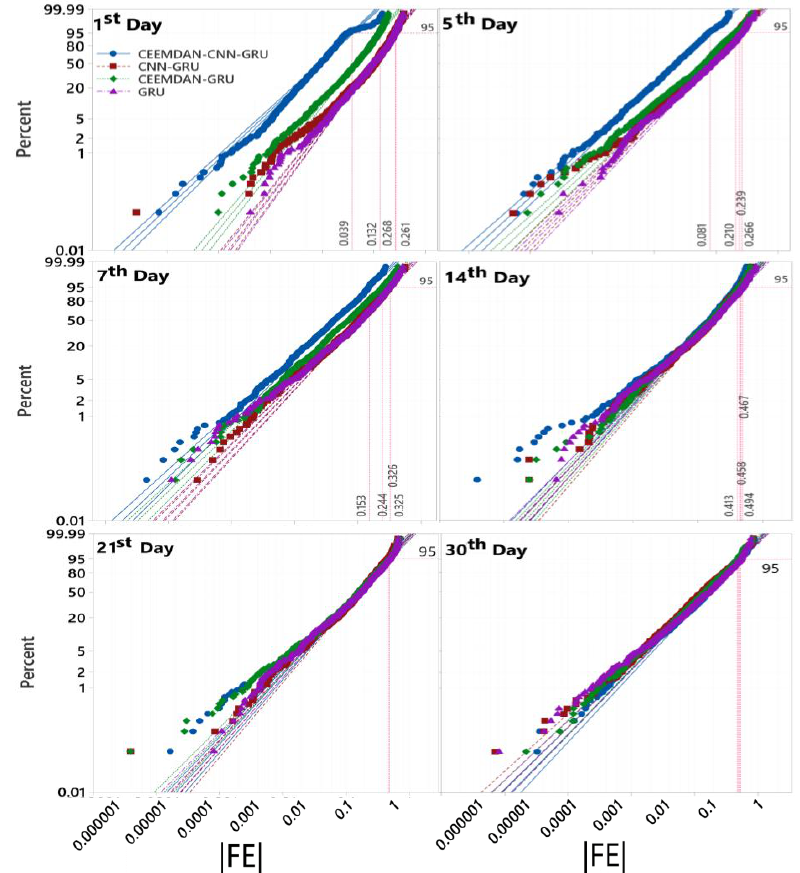
Figure 6. Probability plot (95 percentiles) for hybrid CEEMDAN-CNN-GRU, CNN-GRU, CEEMDAN-GRU, and GRU. model for Menindee at different n th ( n = 1, 5, 7, 14, 21 and 30) day lead time.